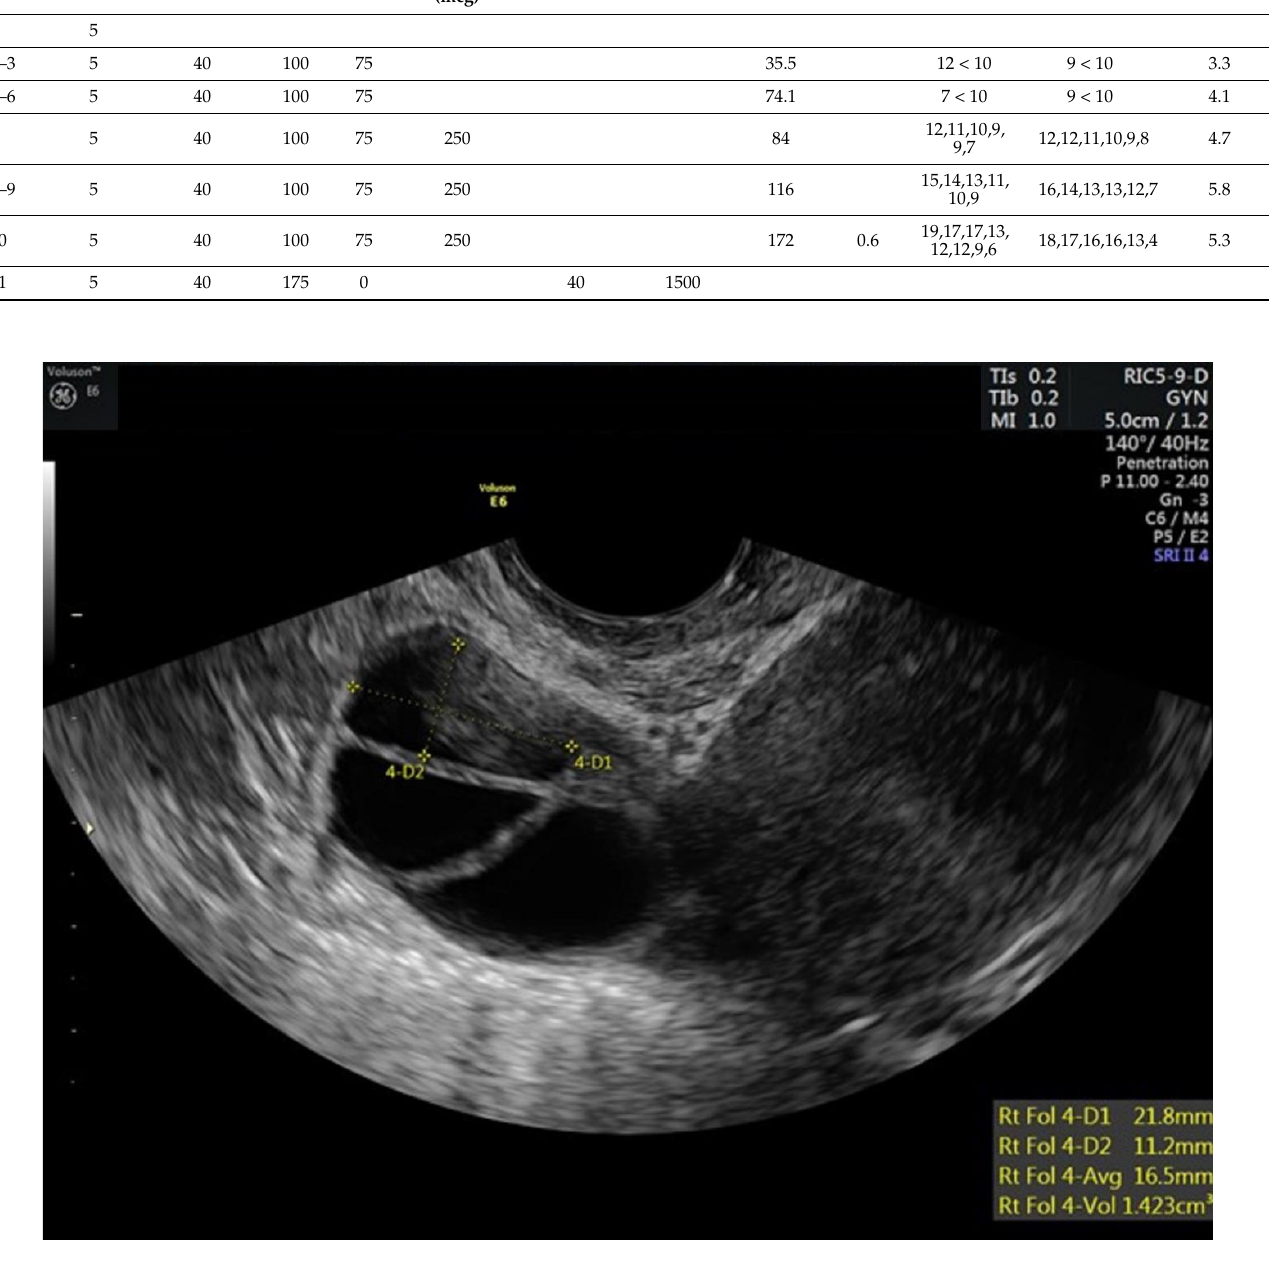
Figure 1. Stimulated right ovary of patient prior to trigger injections.